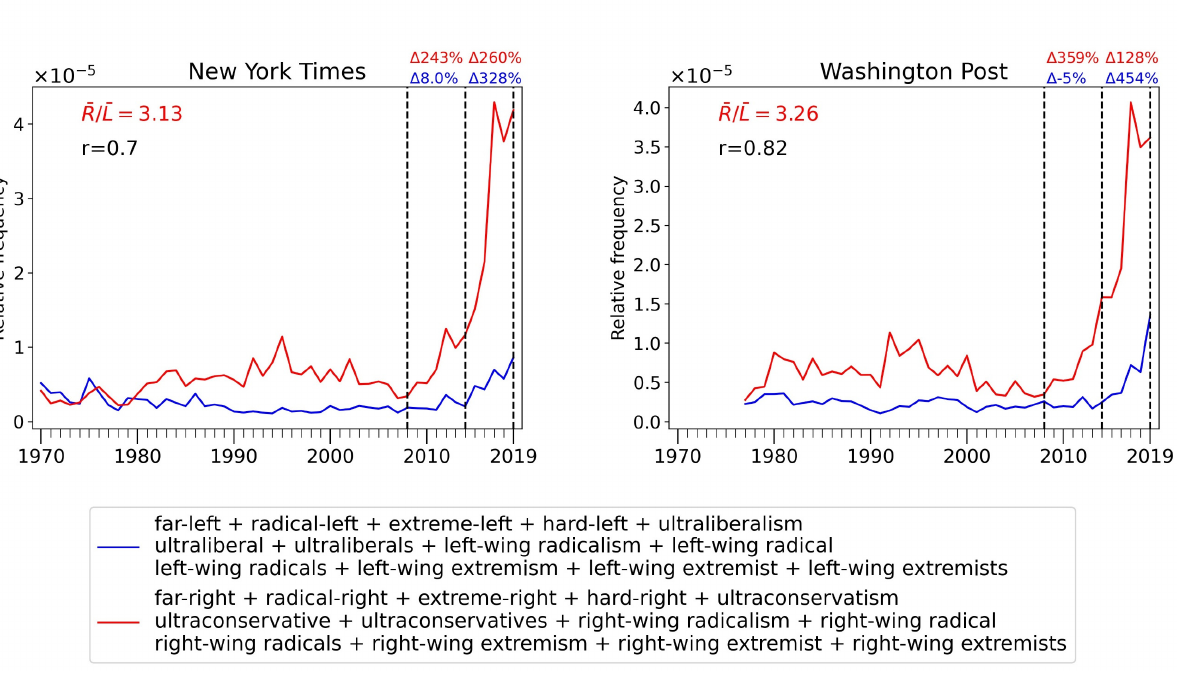
Figure 6. Yearly prevalence of an aggregate set of terms denoting far-right (red) and far-left (blue) political extremism in two prestigious news media outlets: The New York Times and The Washington Post . The average dominant prevalence ratio between both time series is displayed as R / L . The Pearson correlation coefficient, r, between the time series is shown on the top left of each subplot. The years 2008, 2014 and 2019 are highlighted with vertical dashed lines. The percentage growth of target terms between 2008 and 2014 and between 2014 and 2019 for each time series is indicated with color-coded deltas ( Δ ).